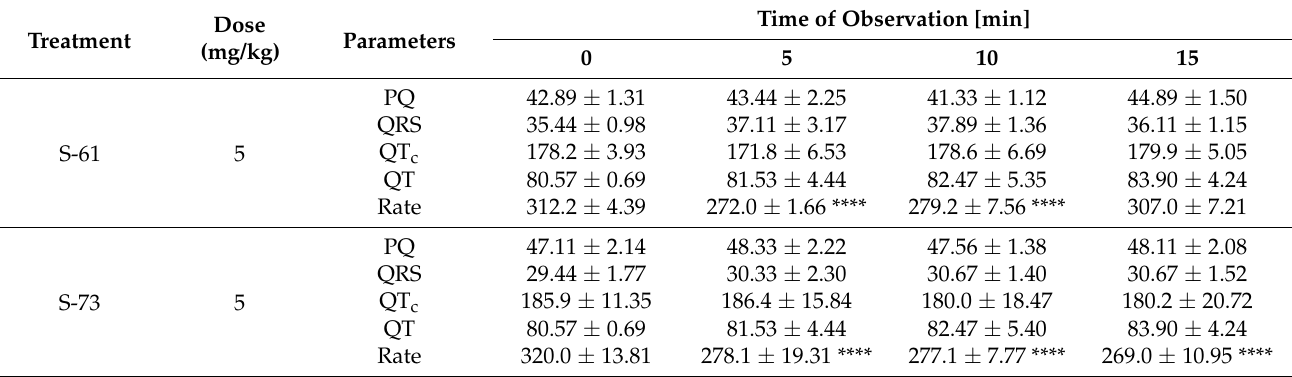
Table 4. The influence of S-61 and S-73 on heart rate and ECG